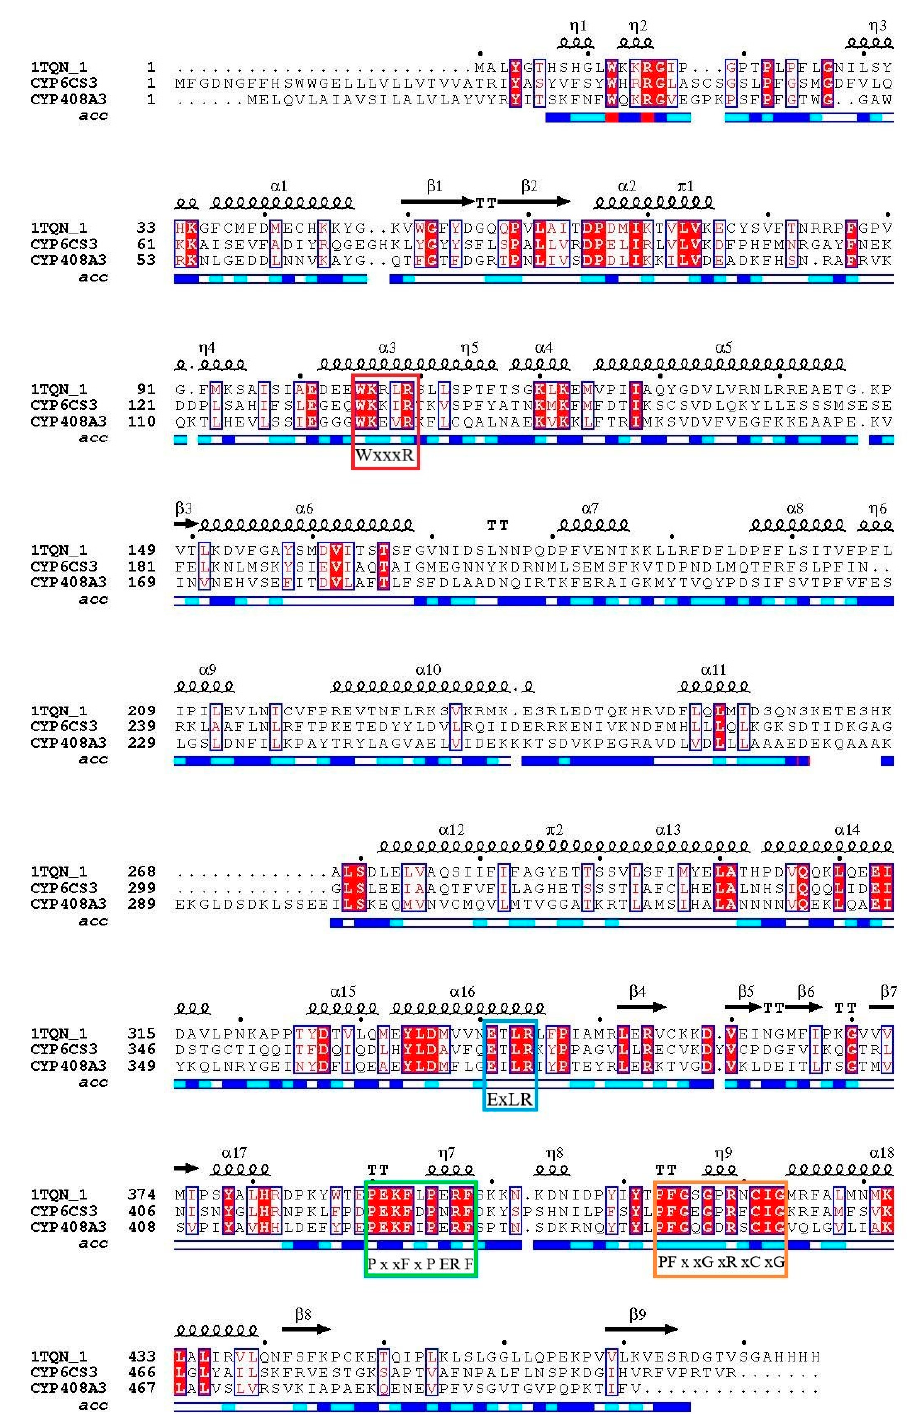
Figure 2. Graph of sequence alignment in three cytochrome P450 genes. The 1TQN-1 sequence is a reference sequence for predicting the function of two amino acid sequences of the P450 gene. The red box located in helix 4 is a conserved sequence, and the amino acid sequence is WxxxR; the blue box located in helix 15 is the conserved sequence, with the amino acid sequence ExLR; the green box of the amino acid sequence is PxxFxPE/DRF; the orange box located in random coil 13 (13, heme binding) is a conserved sequence; and the amino acid sequence is FxxGxxxCxG. To further verify the diversity of the cytochrome P450 genes of S. furcifera during the resistance formation process, we compared the existing P450 sequence in the NCBI library with the evolutionary tree, as shown in Figure 3. The phylogenetic tree showed that